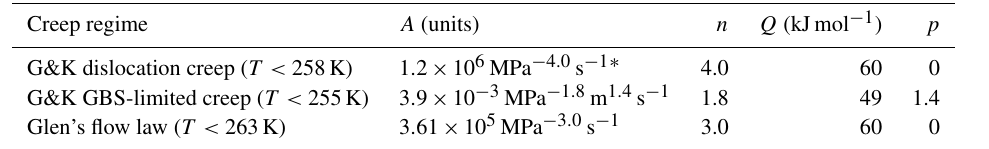
Table 1. Parameters for the simplified composite flow law and for Glen’s flow law given by Eq. (3) that relates grain size, temperature and stress to strain rate. Values taken from Goldsby and Kohlstedt (2001, G&K) and Paterson (1994). The A value for G&K dislocation creep (indicated by ∗ ) was updated and taken from Goldsby (2006).